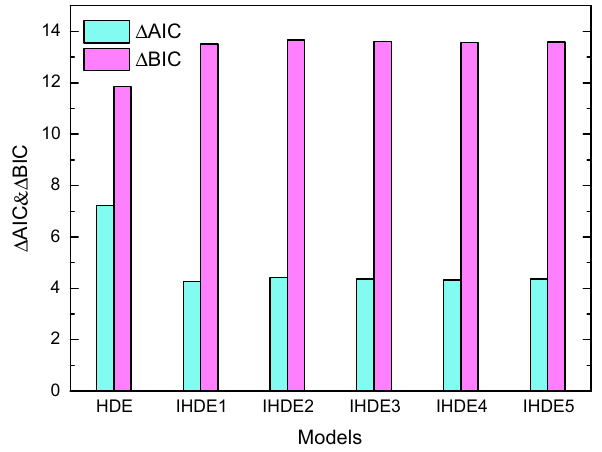
Fig. 1 Graphical representation of the results of (cid:10) AIC and (cid:10) BIC for the HDE model and the IHDE